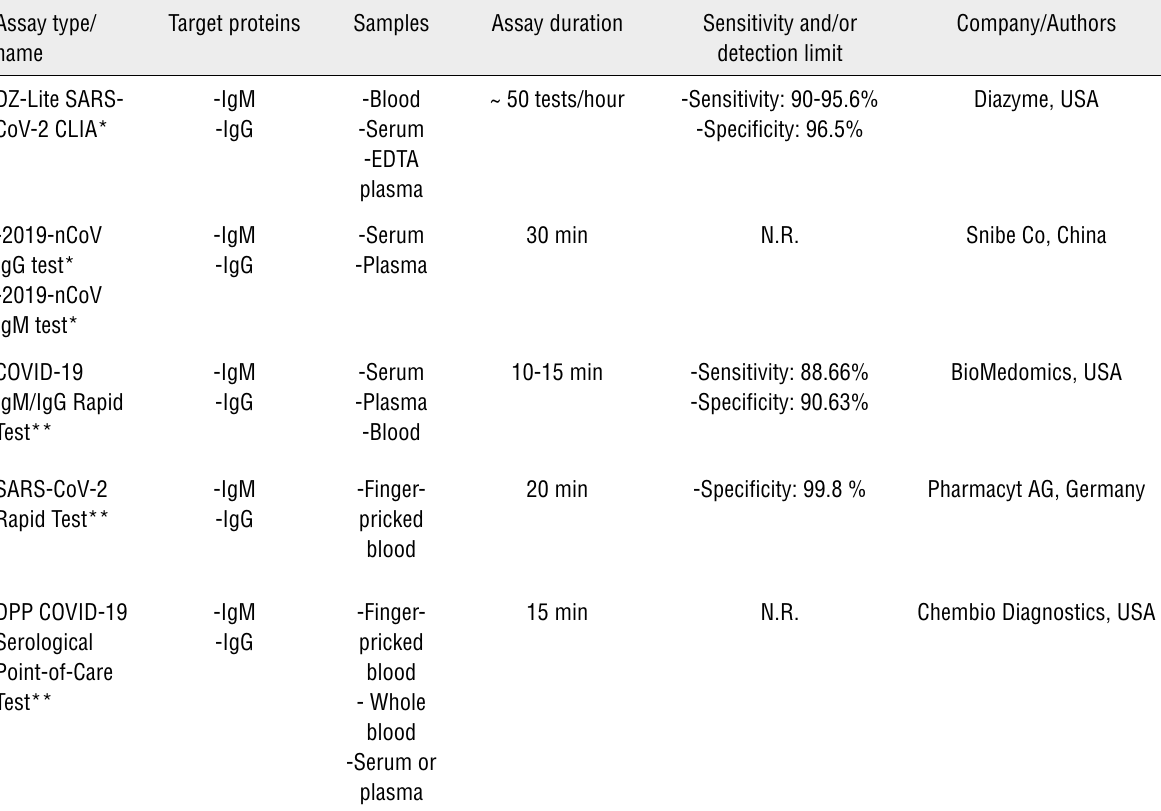
Table 3 - Summary of rapid in vitro diagnostic serological immunoassays based on SARS-CoV-2 detection of viral proteins and